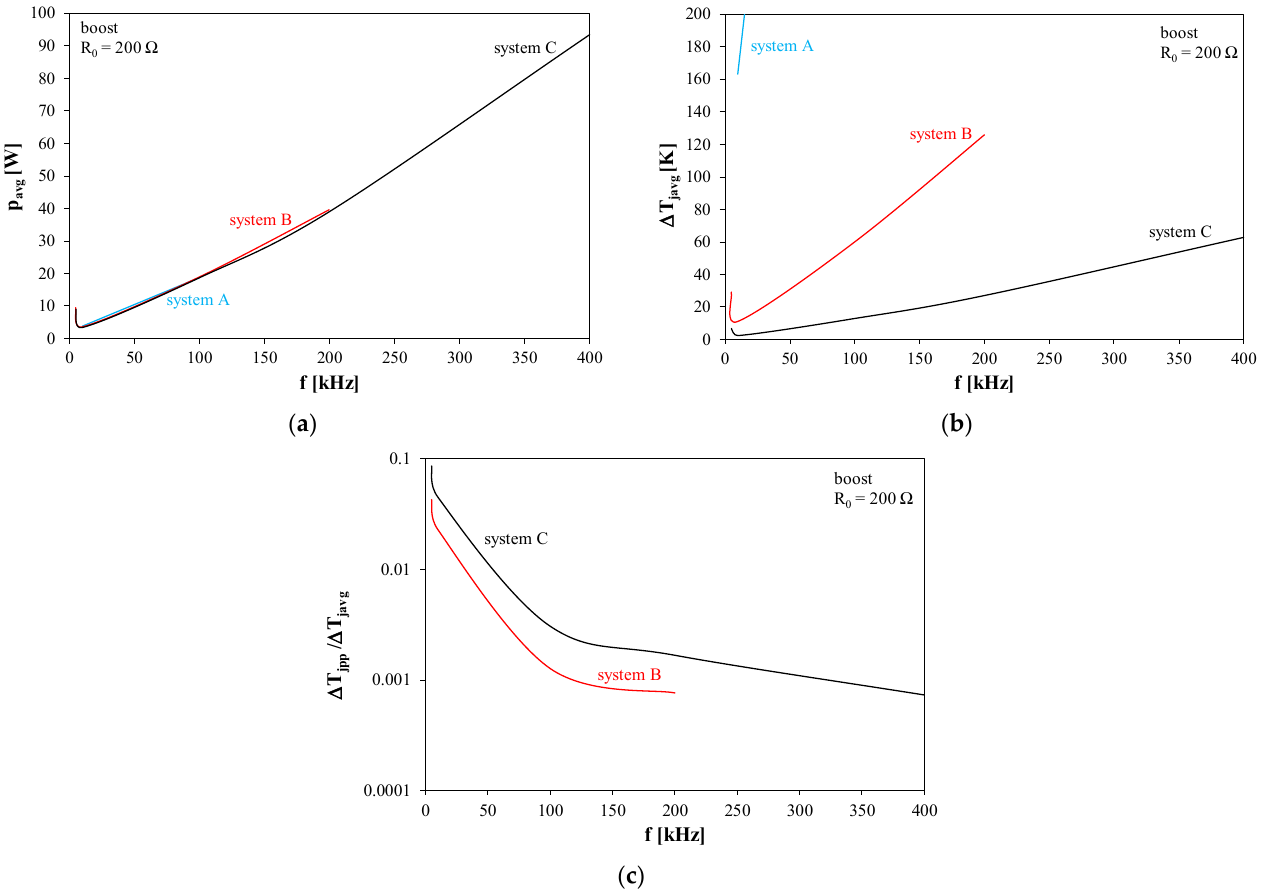
and load resistance R 0 = 25 Ω .